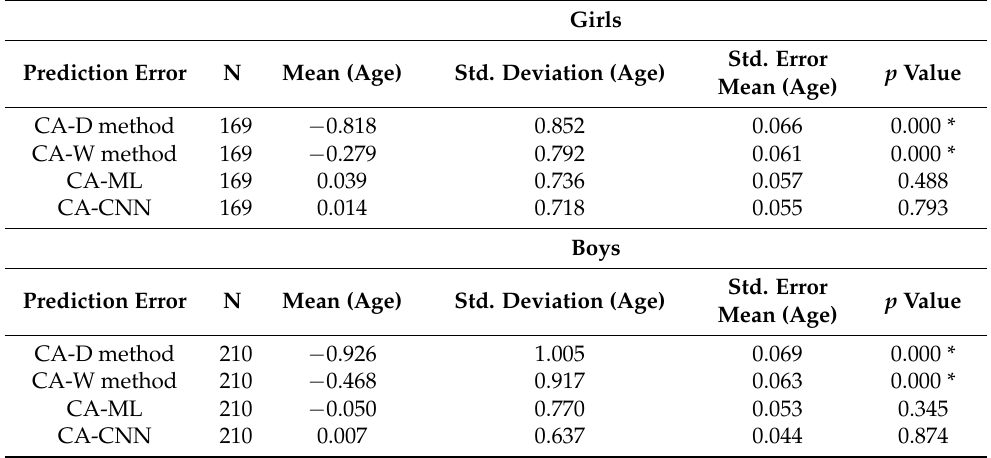
Table 1. The performance of studied methods in predicting CA of healthy